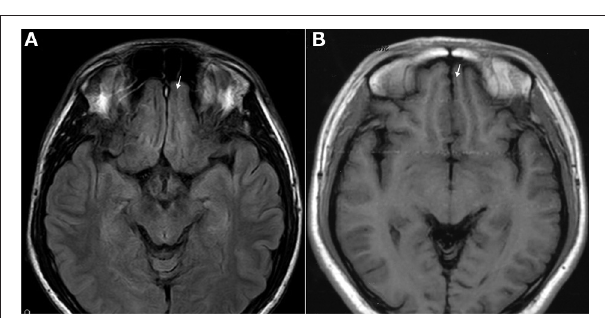
FIGURE 7 | T1 images showed atrophic basal prefrontal (gyrus rectus) lesion of a 0.5 years ketamine addicts who took three drugs including ketamine (A). (B) Control with no retraction of gyrus rectus (arrow).